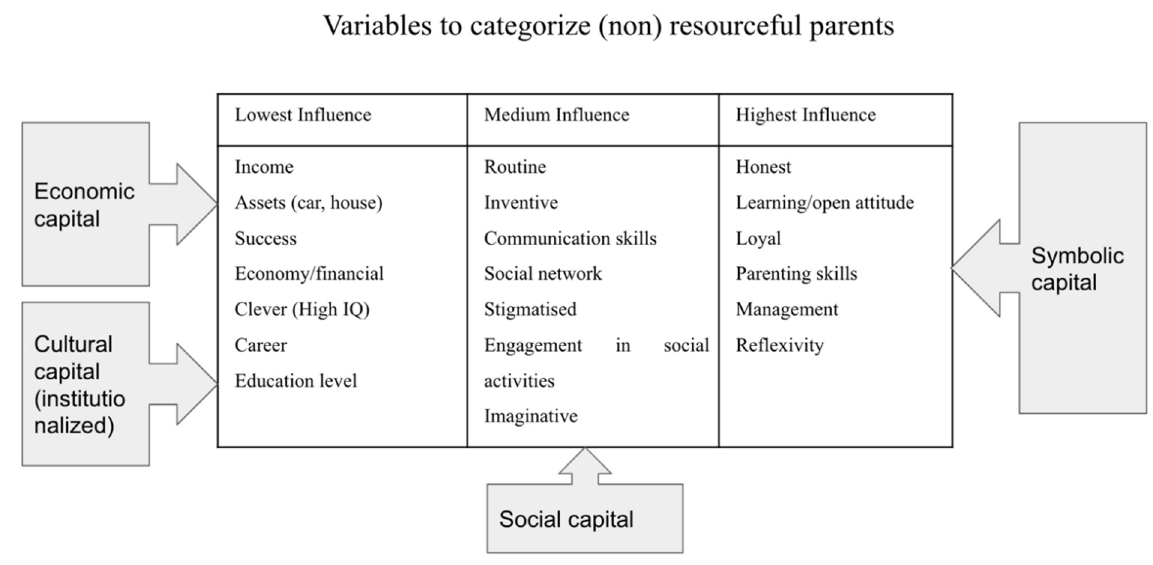
Figure 3. Variables analyzed using the concept of capitals.